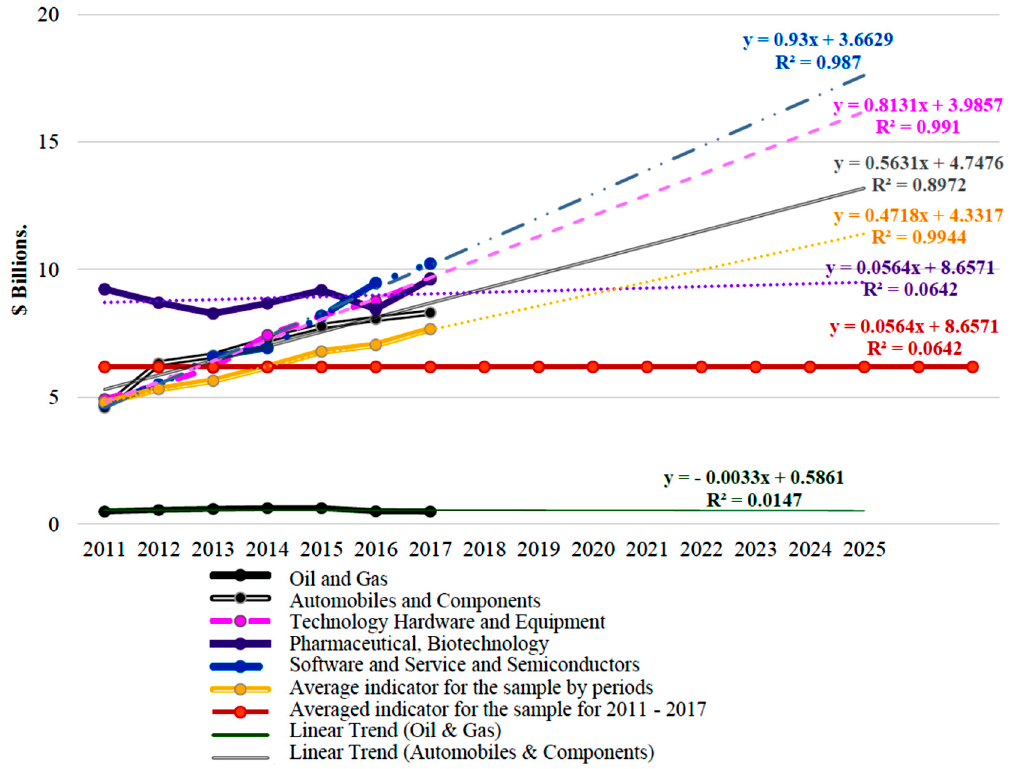
Figure 2. Forecast (linear trend) of investments in R&D of Oil Companies in comparison with companies in other industries until 2025, in billions of dollars. Source: calc. by author by data [56].